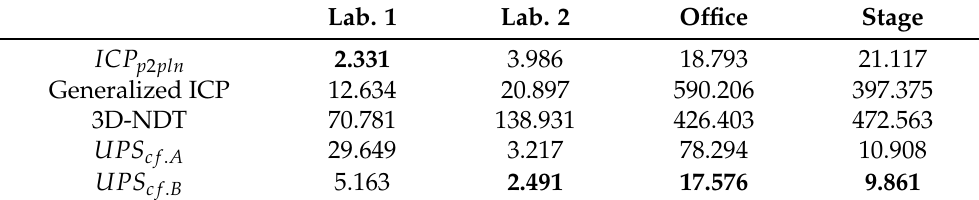
Table 9. Running time (in seconds) to align pairs of indoor scenes (in seconds).